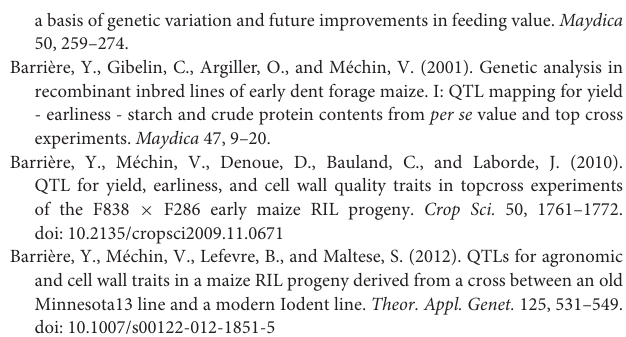
Supplemental Table S2 | Constitutive and responsive QTLs details. Supplemental Table S3 | QTL detection per irrigation